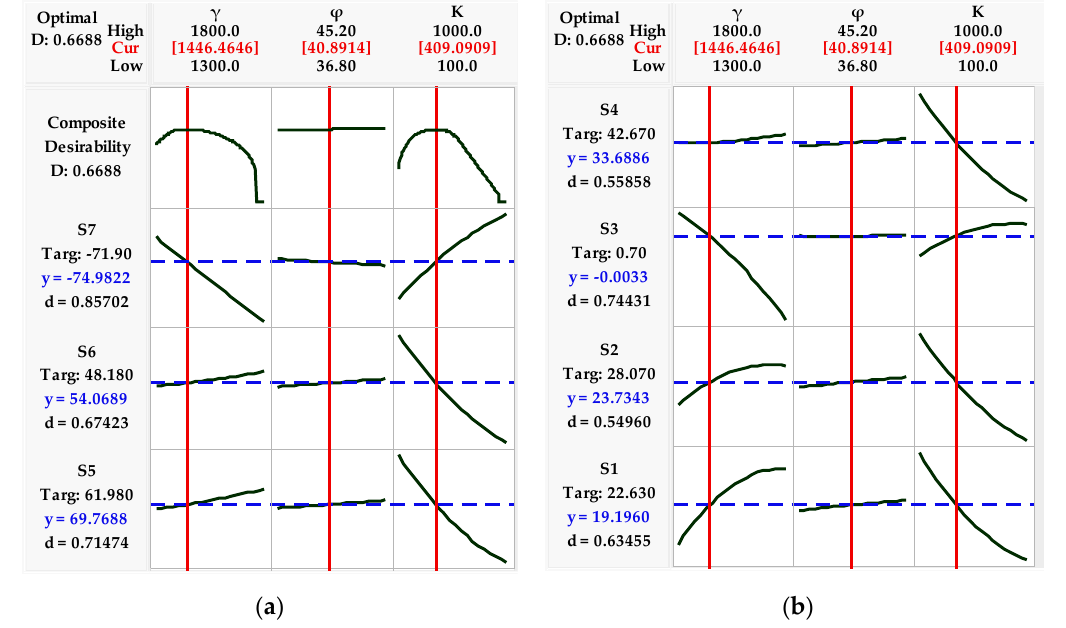
Figure 8. Updated properties: ( a ) Responses S4 ~ S7 desirability ( b ) Responses S1~S4 desirability.